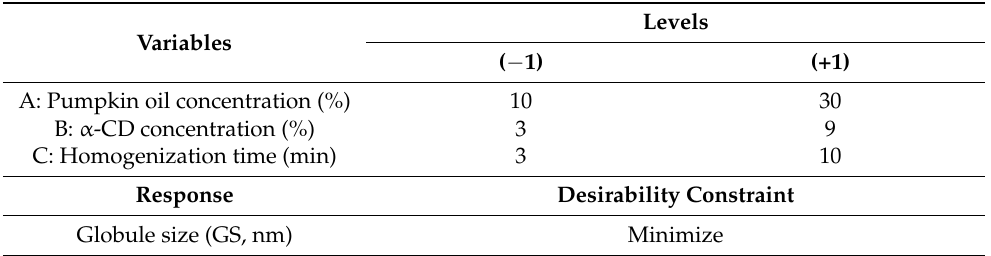
Table 1. Independent variables’ levels and desirability constraints for the globule sizes used in Box–Behnken for the optimization of CTD-loaded